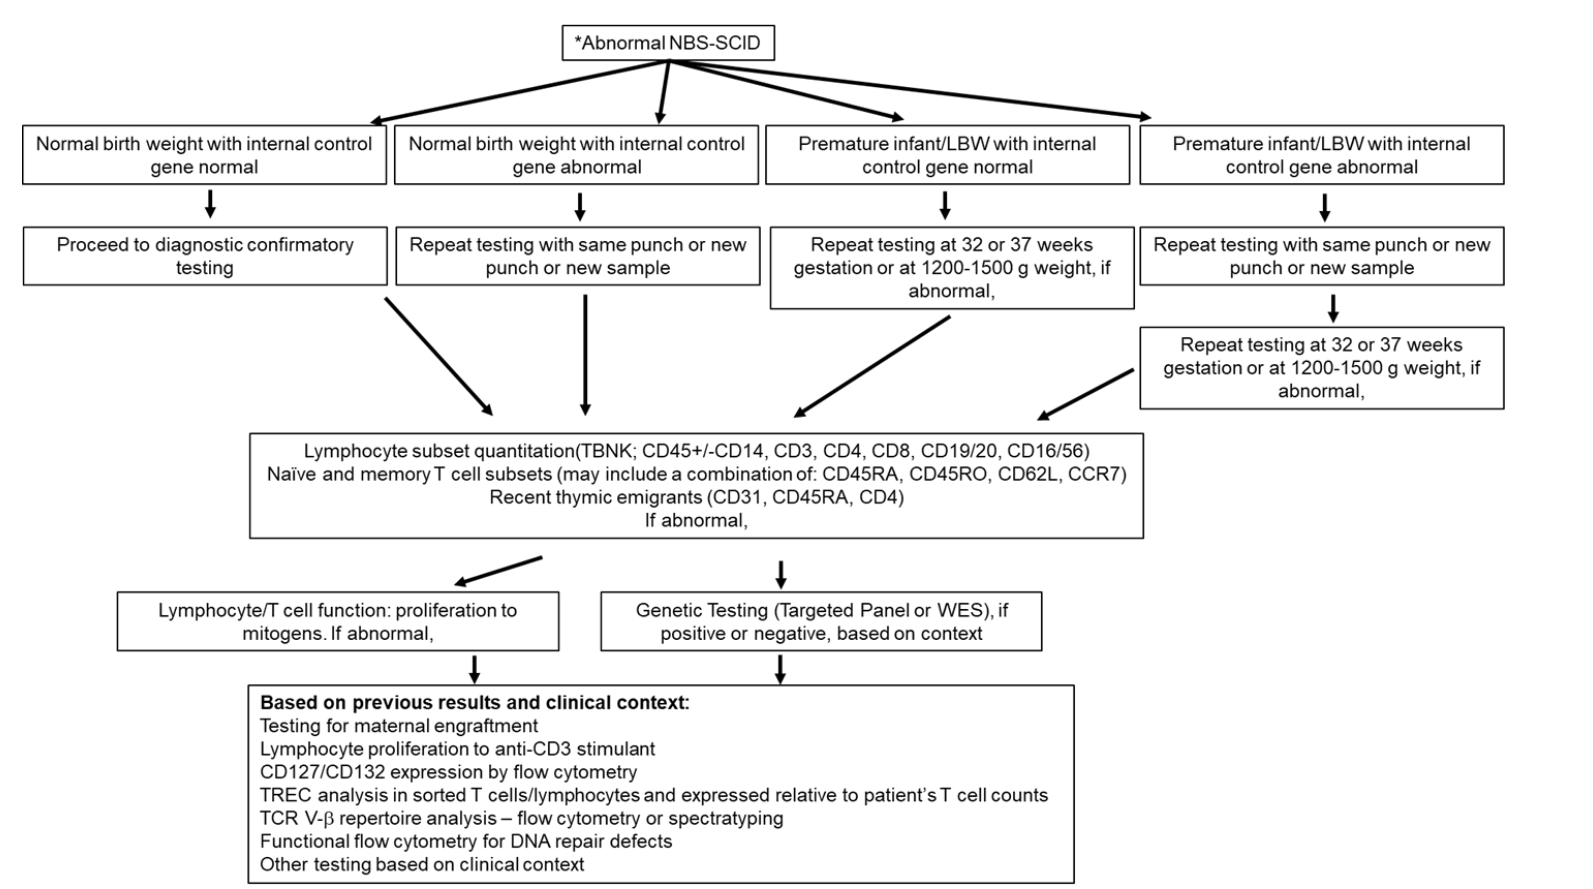
Figure 1. Follow up testing strategies for an abnormal newborn screen for severe combined immunodeficiency (*NBS SCID) result. NBS SCID includes PCR amplification of T cell receptor excision circle (TREC) and an internal control gene, generally beta-actin or RNAse P. An abnormal result (low TREC and/or low internal control gene) may trigger confirmatory flow cytometry testing, repeat DBS and/or repeat TREC analysis or repeating DBS and TREC analysis in preterm infants when closer to term birth weight or age. Flow cytometry analysis includes basic lymphocyte subset phenotyping and may include additional markers for naïve and memory T cells and recent thymic emigrants, followed by analysis of T cell function, genetic and other immunological analyses as deemed appropriate.